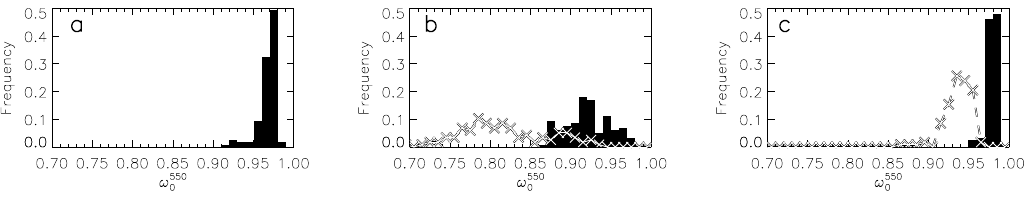
Fig. 7. Histograms of single scattering albedo values at 550nm from horizontal legs during Fennec: (a) from observations as measured by the nephelometer and PSAP behind Rosemount inlets; (b) Calculated using the full size distributions as shown in Fig. 5; (c) Calculated using size distributions adjusted for inlet and pipe losses and enhancements, i.e. with reduced coarse mode. Solid bars in (b) and (c) assume m = 1 . 53 − 0 . 001 i , dashed lines and crosses assume m = 1 . 53 − 0 . 003 i